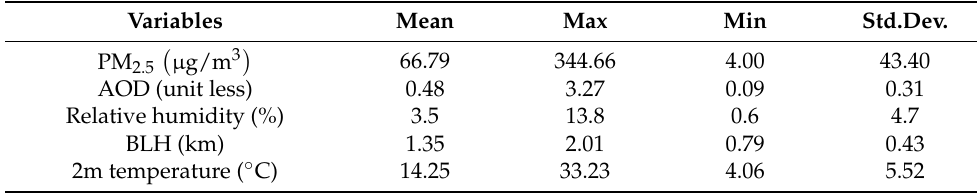
Table 2. The descriptive statistics of the variables of 2017.